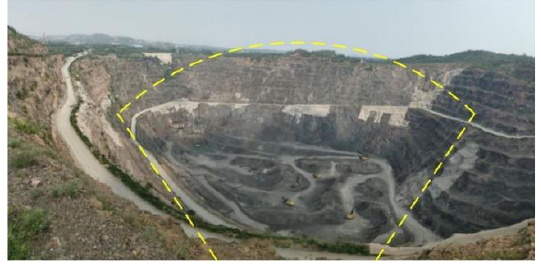
Figure 2. A photo of the Malanzhuang open-pit. This monitoring area is defined as the 3D observation scenario due to the steep topography.